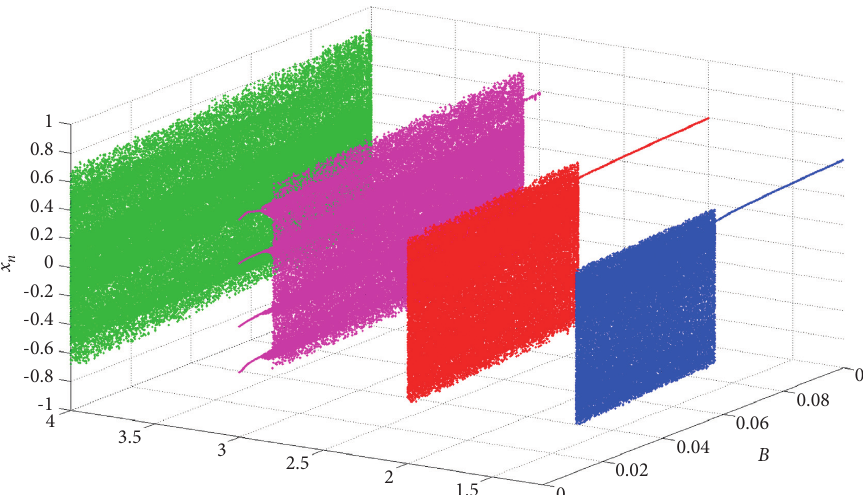
Figure 3: Different bifurcation diagrams of the fractional map (8) in three-dimensional space with the variation of system parameter B: blue diagram for μ � 1; red diagram for μ � 0 . 8; magneta diagram for μ � 0 . 6; green diagram for μ � 0 . 4.